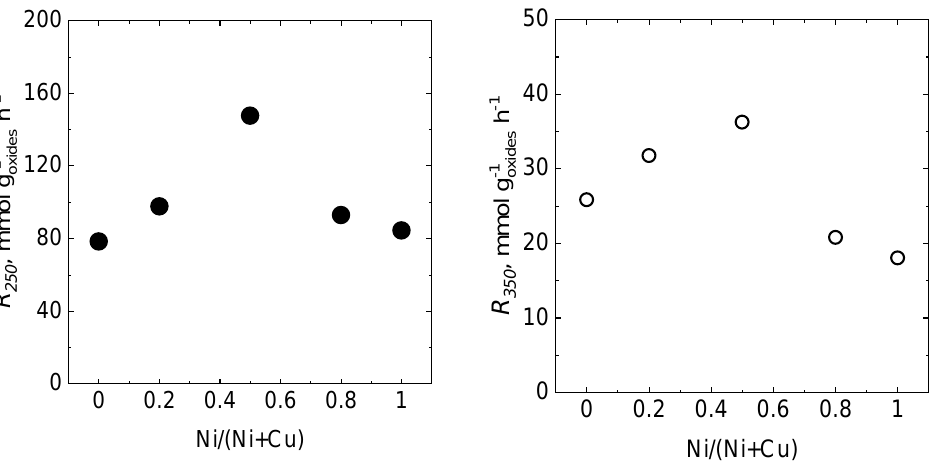
Figure 9. Catalytic activity of sputtered catalysts expressed as specific reaction rate R 250 in the oxidation of ethanol ( left ), and specific reaction rate R 350 in the oxidation of toluene ( right ) in dependence on Ni/(Ni + Cu) molar ratio.